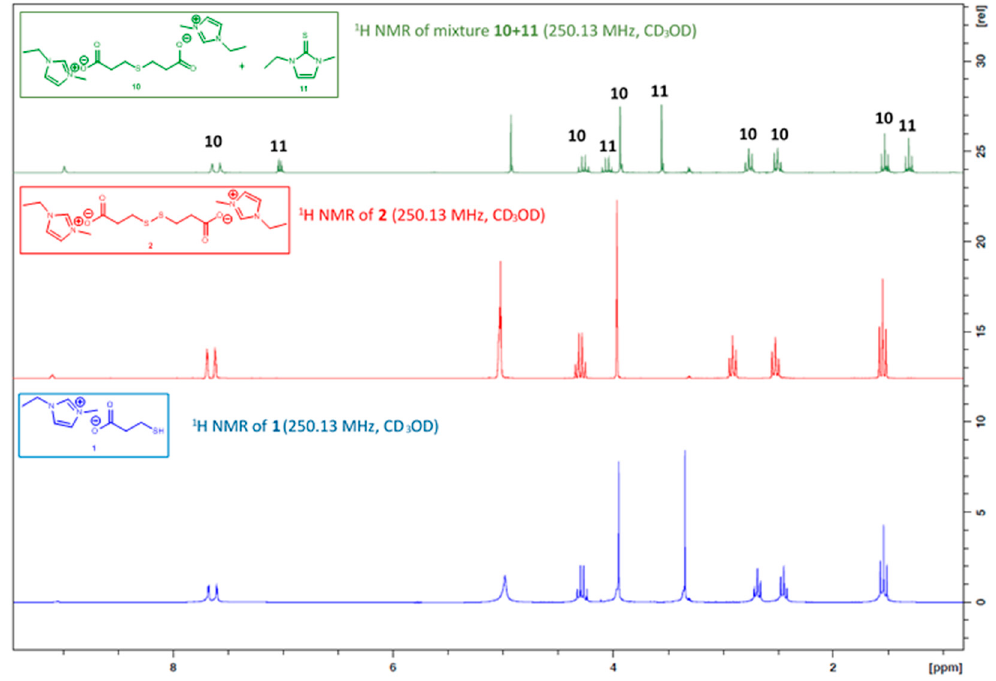
Figure 2. 1 H-NMR spectra of compound 1 (blue), compound 2 (red), and mixture of 10 and 11 obtained by heating 2 at 120 °C for 4 h (green).